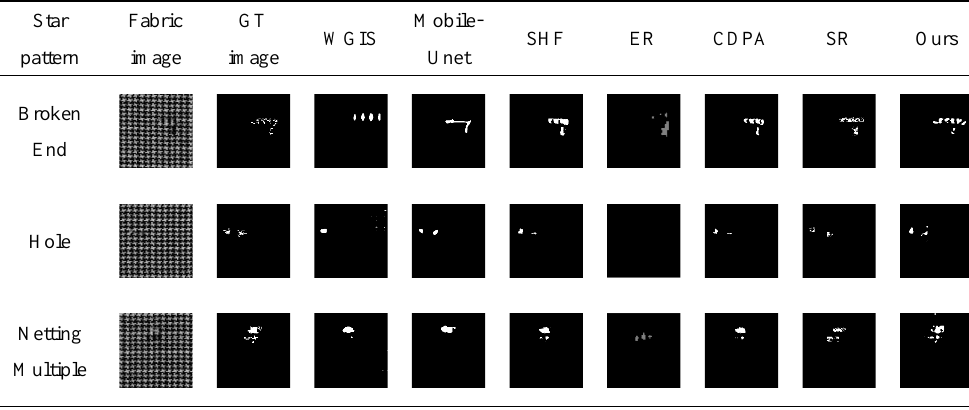
Figure 13. Each row depicts the detect inspection exemplars for 7 algorithms of a specific detection type. From top to bottom, these types are Broken End, Hole and Netting Multiple.